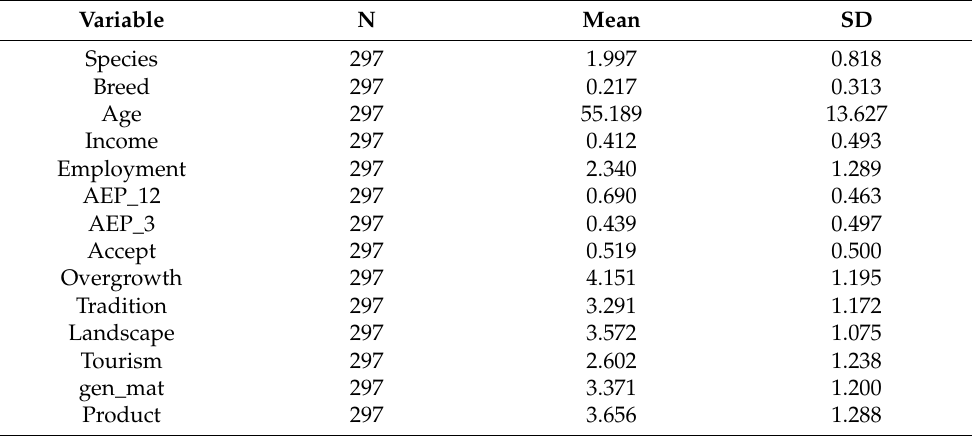
Table 4. Descriptive